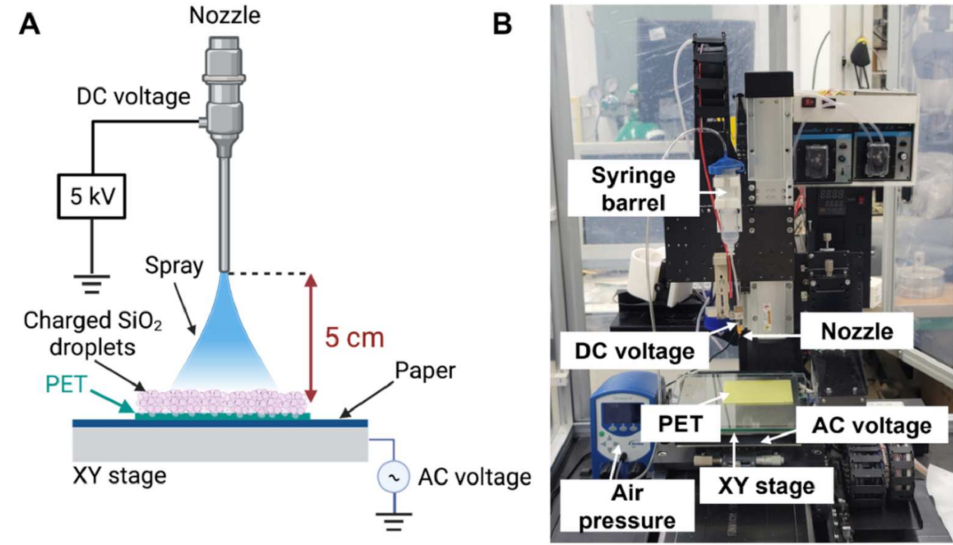
Figure 1. Fabrication and characterization of the electrosprayed SiO 2 surface. ( A ) A schematic illustration of electrospray SiO 2 -deposited surface fabrication on polyethylene terephthalate (PET) substrate (created with BioRender.com). ( B ) A photograph of the experimental